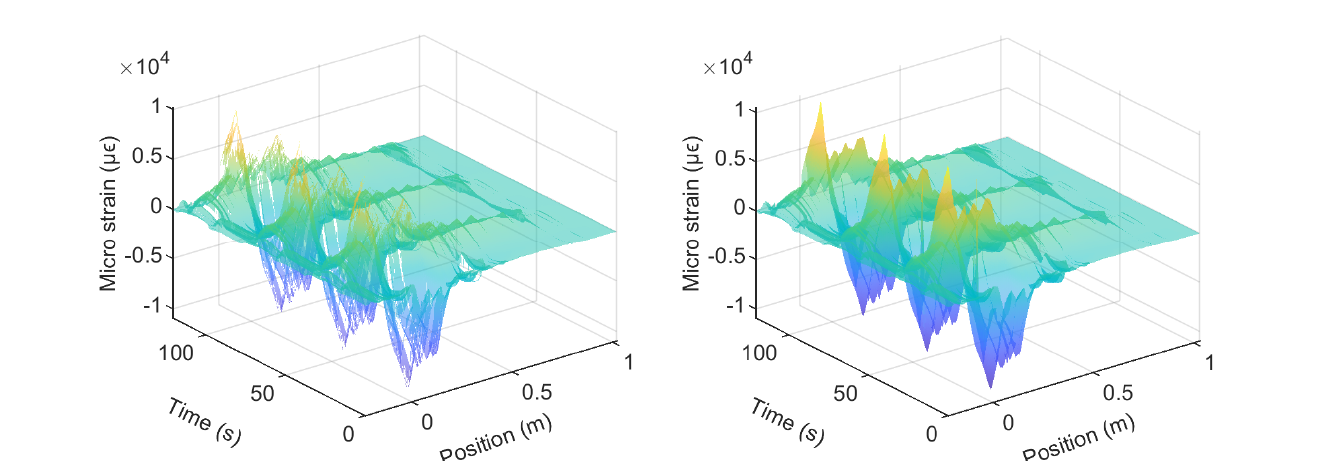
Figure 21. Reconstruction of the fiber-optic strain measurement (Polyimide, rebar) for the right side of the beam at a drift level of 1.76 %.